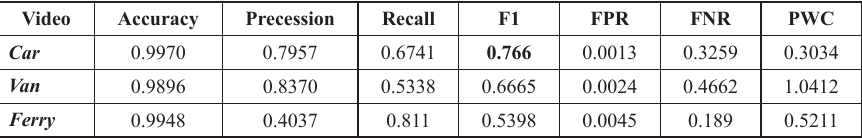
Table 2. Performance metrics results of applying SuBSENSE model